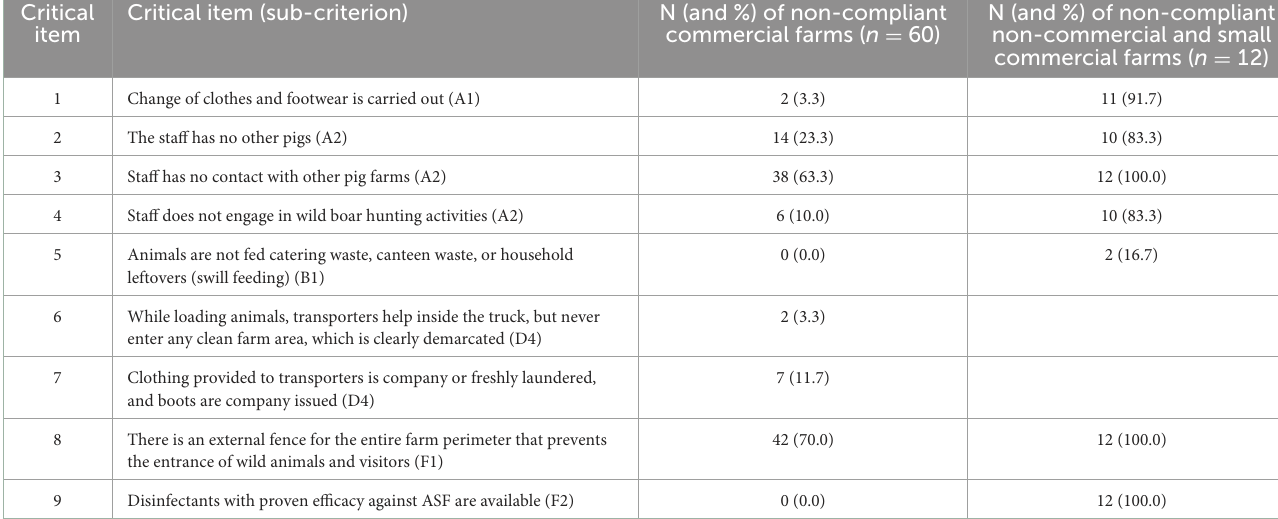
TABLE 2 List of the 9 “Critical items” selected by the expert’s panel, with reference to the sub-criterion in which they are included. Critical item